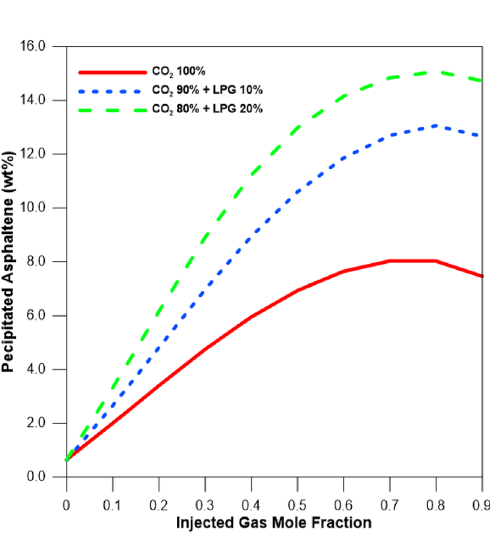
Figure 2. Amount of asphaltene precipitation with various CO 2 and LPG concentrations at a reservoir pressure of 15,857 kPa and a temperature of 100